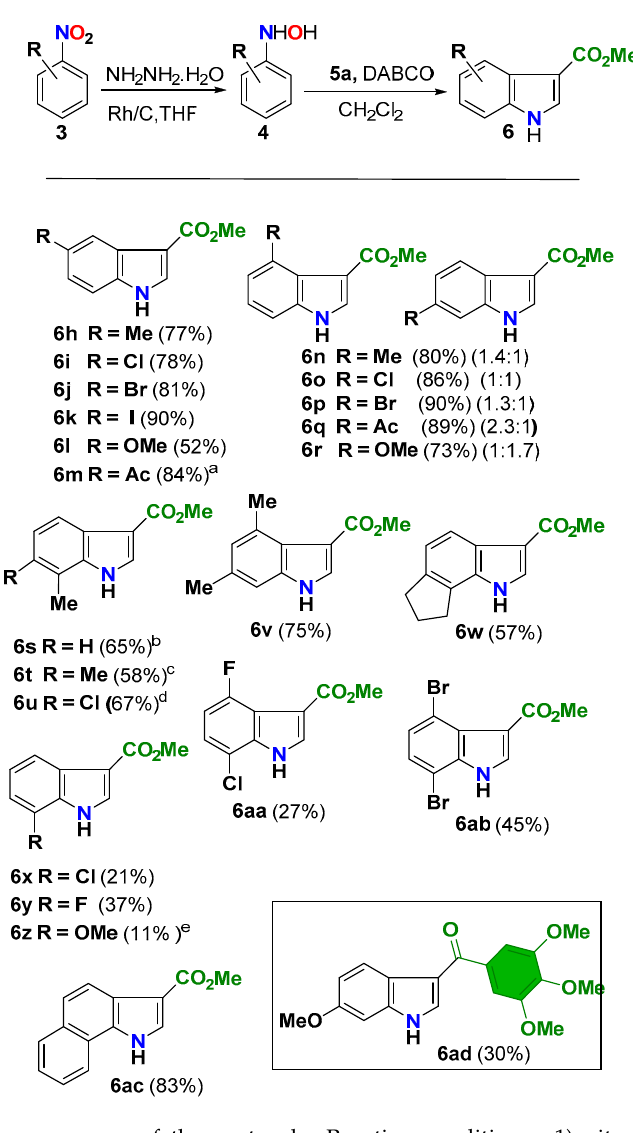
Scheme 5. Nitroarene scope of the protocol. Reaction conditions: 1) nitroarene 3 (4 mmol),